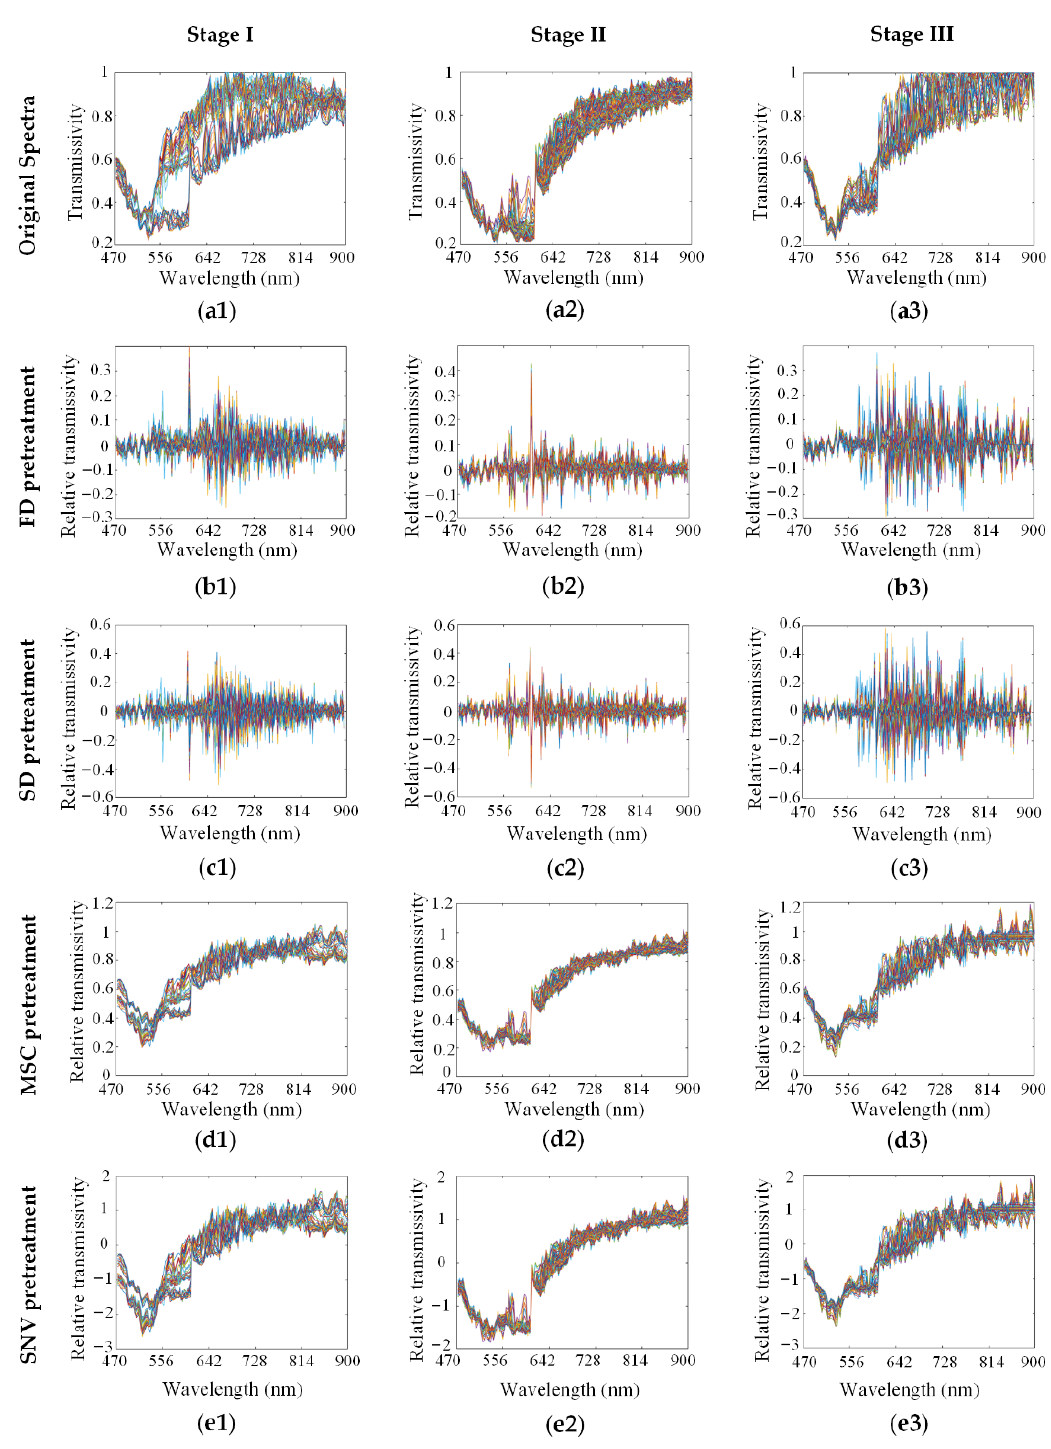
Figure 3. Spectra preprocessing of SCC at different clinical stages: stage I, stage II and stage III, respectively. ( a1 – a3 ) Original spectra; ( b1 – b3 ) preprocessed spectra by FD; ( c1 – c3 ) preprocessed spectra by SD; ( d1 – d3 ) preprocessed spectra by MSC; ( e1 – e3 ) preprocessed spectra by SNV. The different color lines represented the spectra of different sample pixels of the ROIs.